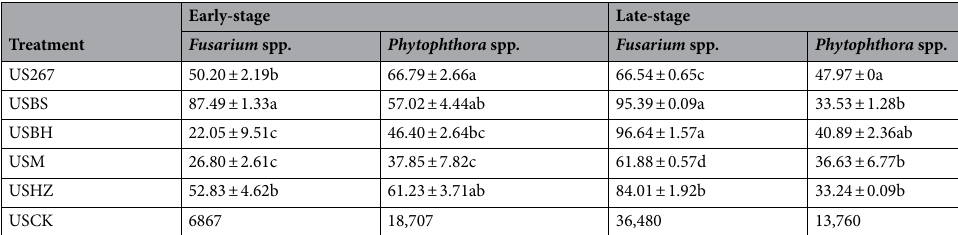
Table 2. Average number of Fusarium spp. and Phytophthora spp. in substrate and percent relative efficacy of biofertilizers in the early and late stages of cucumber growth. Means (N = 3) within the same time period accompanied by the same letter are not statistically different (P = 0.05), according to Duncan’s new Multiple- Range test. US267 = T. 267 biofertilizer added to substrate; USBH = B. subtilis and T. harzianum biofertilizers added to substrate; USBS = B. subtilis biofertilizer added to substrate; USM = Compound biofertilizer added to substrate; USHZ = T. harzianum biofertilizer added to substrate; USCK = Untreated